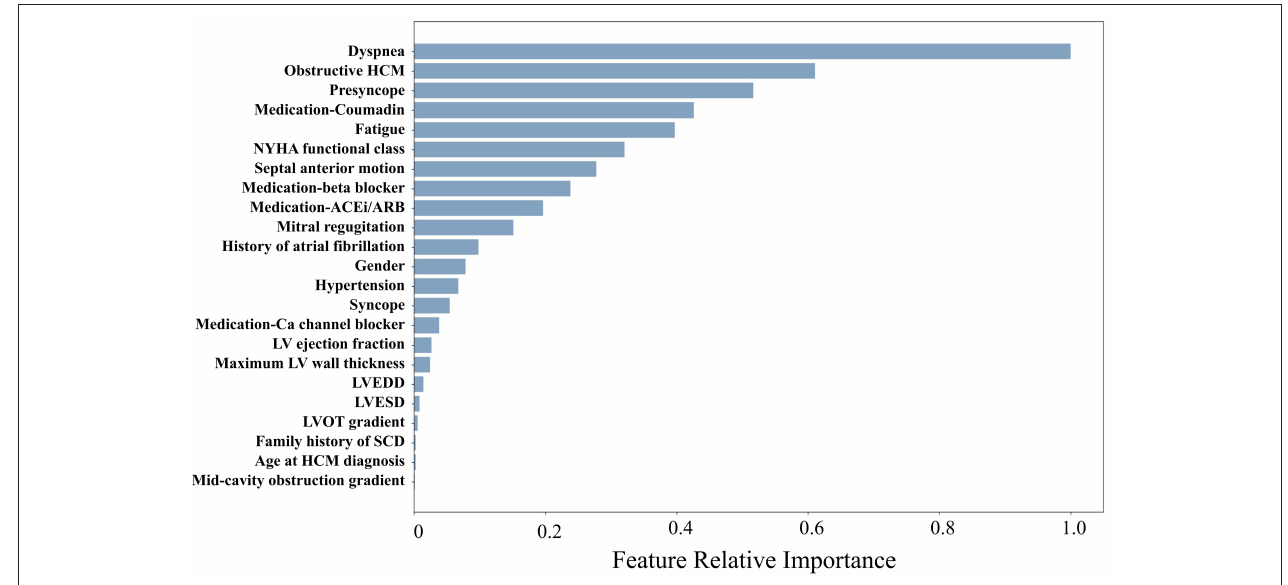
FIGURE 2 | Relative importance scores for the risk factors included in the study (only factors with nonzero scores are displayed).